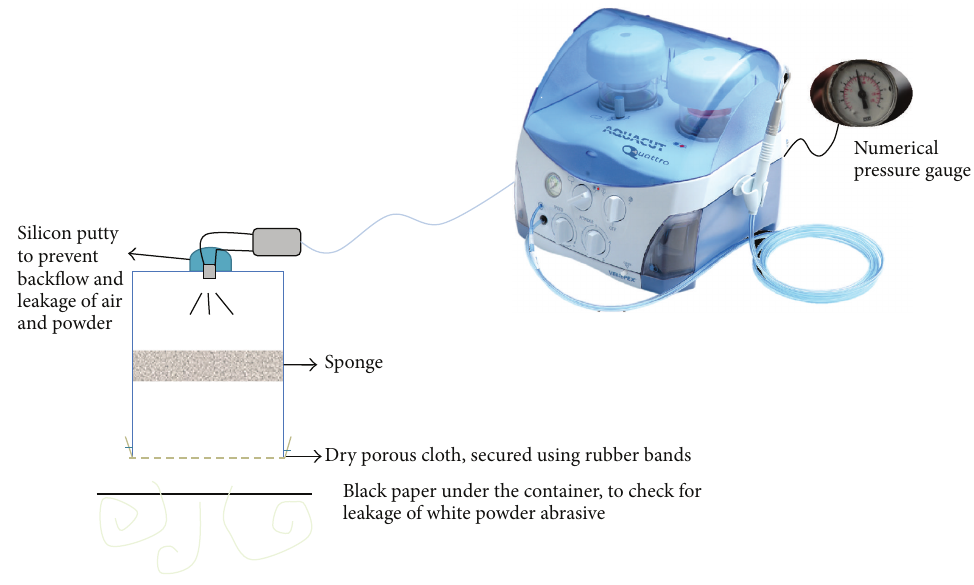
Figure 3: Air abrasion set-up of the abrasive powder outflow